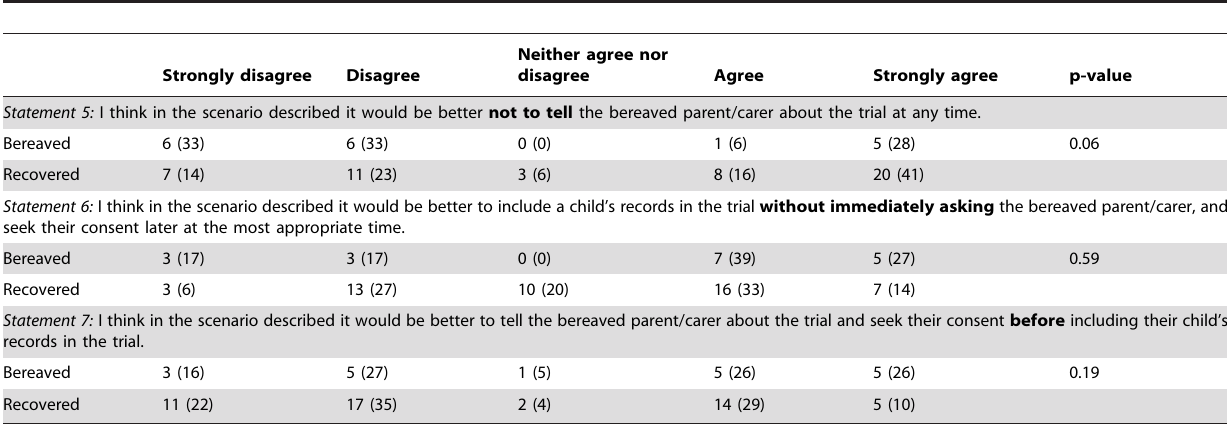
Table 2. Scenario B: If a child could not be resuscitated and unfortunately died in the emergency department we would want to tell the parents that their child had been given the fluid as part of a clinical trial of emergency